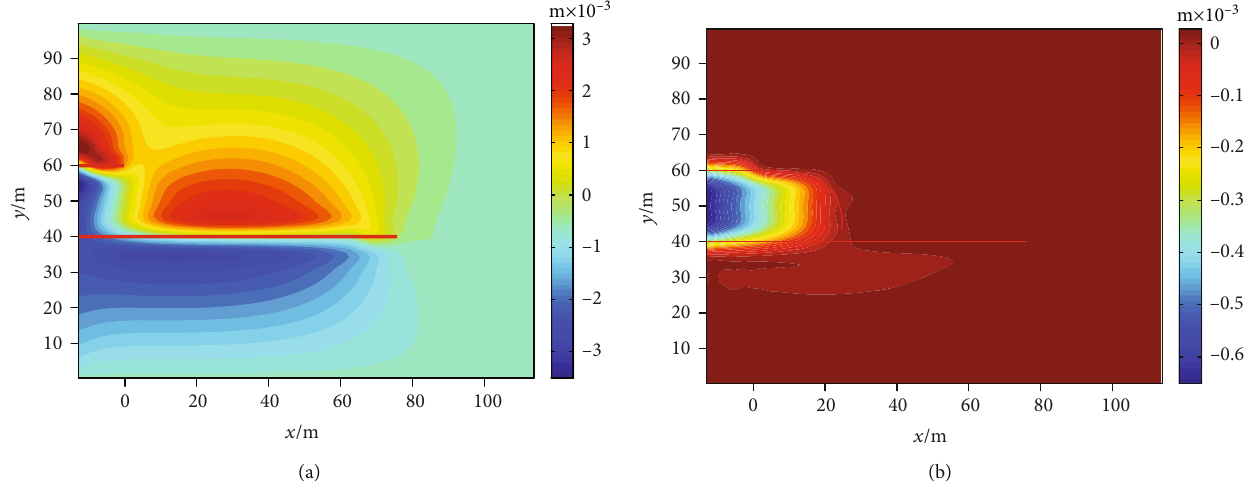
Figure 14: Displacement distribution in the sequential fracturing process with double fractures.